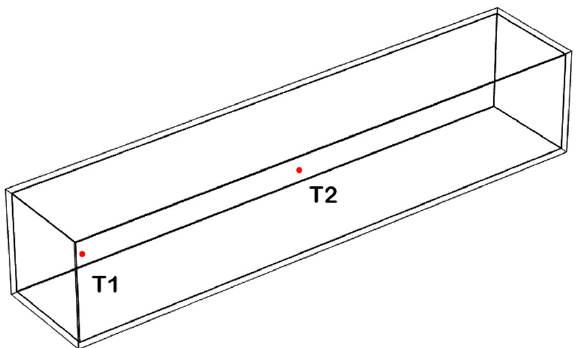
Figure 11. The model of a full-scale refrigerated semi-trailer with marked measurement points for plotting the graphs of internal temperature.